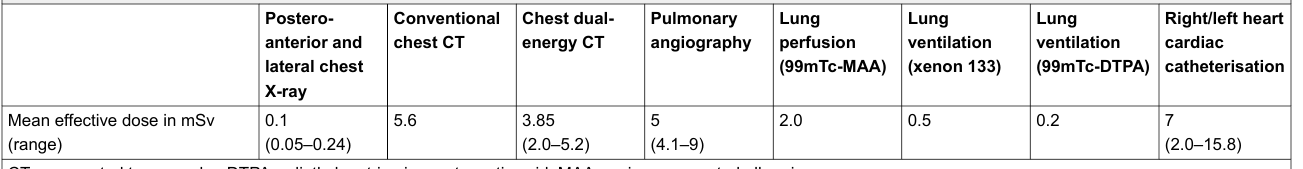
Right/left heart cardiac catheterisation